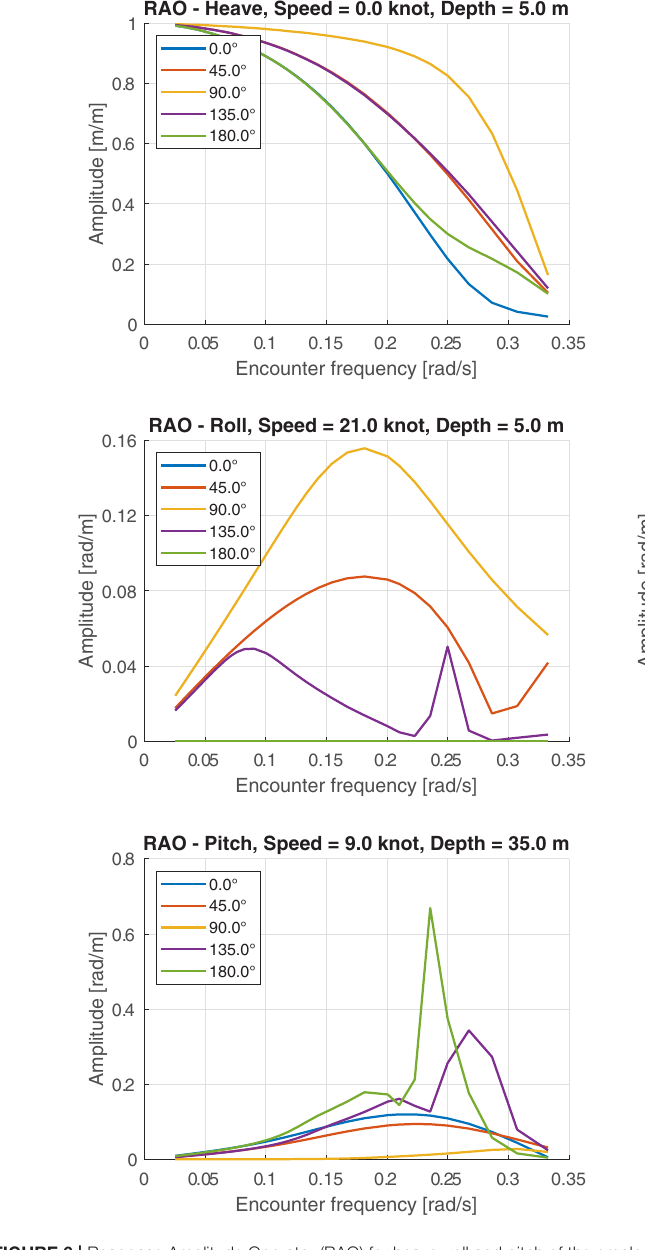
assessment of workable conditions within the 5-day